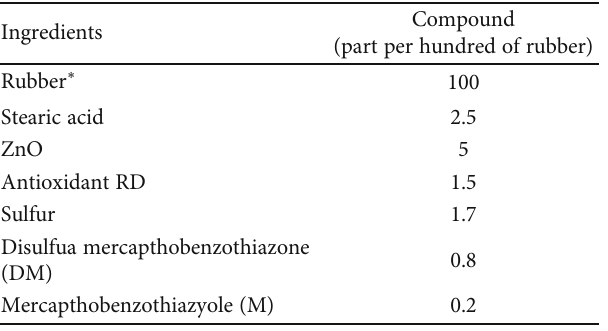
Figure 1: Schematic overview of the graft copolymerization of MMA onto DPNR. Table 1: Typical recipe used for the vulcanization of rubber